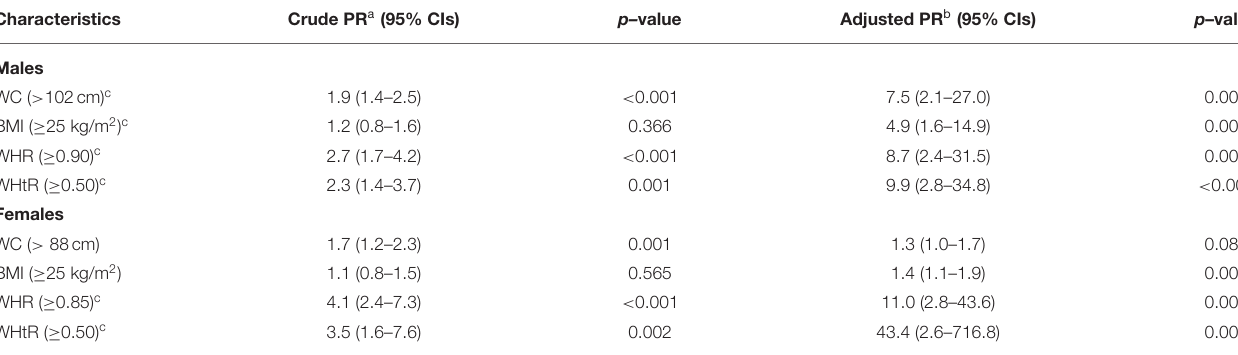
TABLE 4 | Crude and adjusted prevalence ratios (PRs) of anthropometric indices for identifying high CVD risk ( ≥ 10% using the Framingham Risk Score).